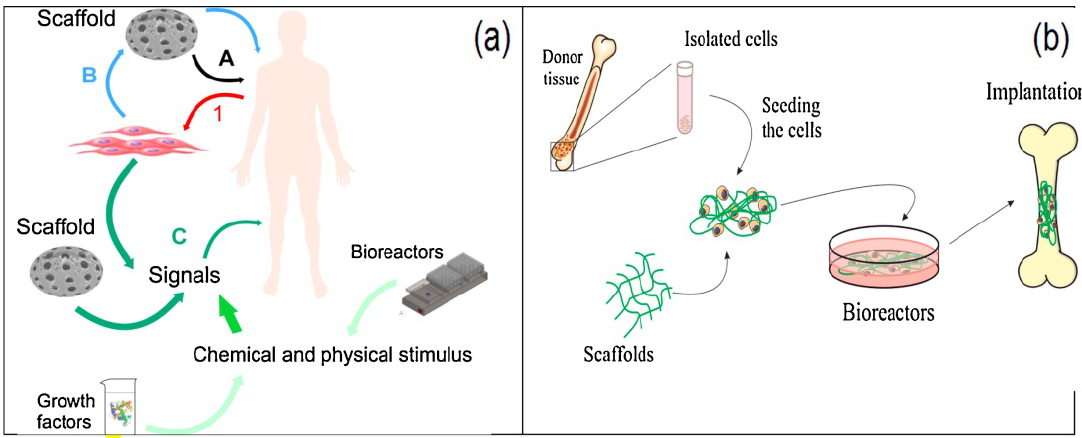
Figure 16. ( a ) Schematic diagram of the different strategies in the tissue engineering field: 1—the cells harvested directly from the patient; A—scaffold implanted directly; B—cells cultured in scaffold and then implanted; C—cells cultured in scaffold with appropriate signal and then implanted. ( b ) Tissue engineering strategies for bone regeneration [192].